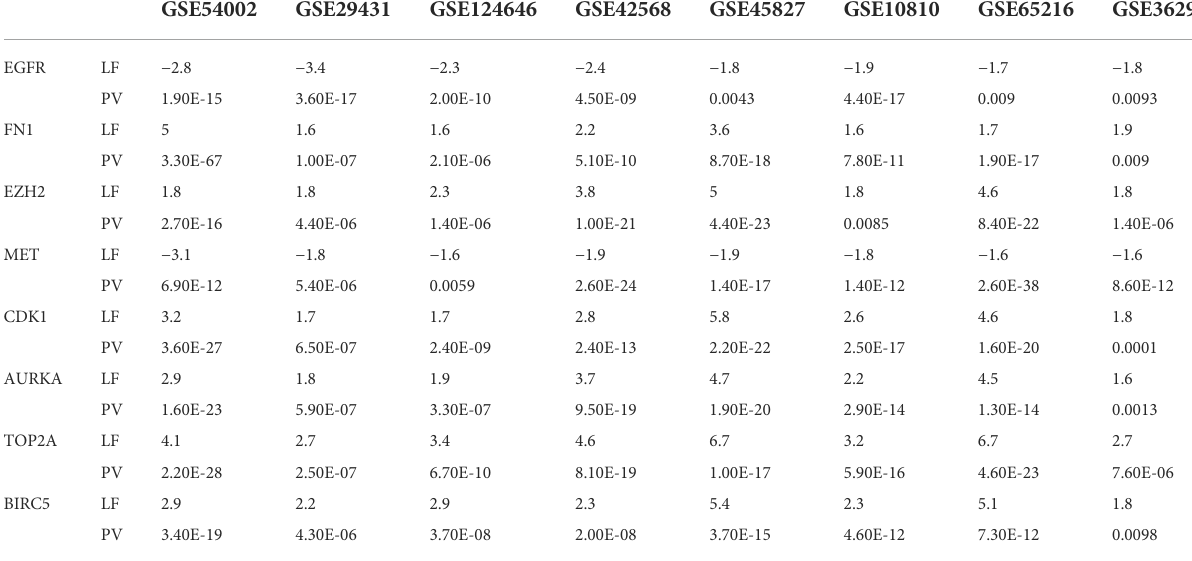
TABLE 4 List of KGS included with p values and logFC values on eight sets of